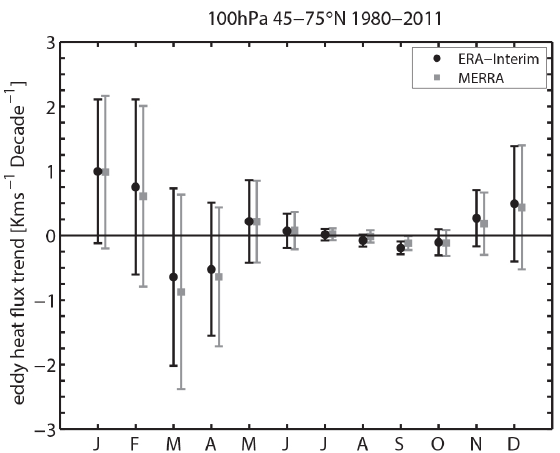
Fig. 2. Eddy heat flux trend at 100hPa from ERA-Interim (black) and MERRA (gray) data (1980–2011). The figure shows the area- weighted average over 45–75 ◦ N. Mean trends are calculated from eddy heat flux averages over the previous 45 days. Vertical bars show the 2 σ